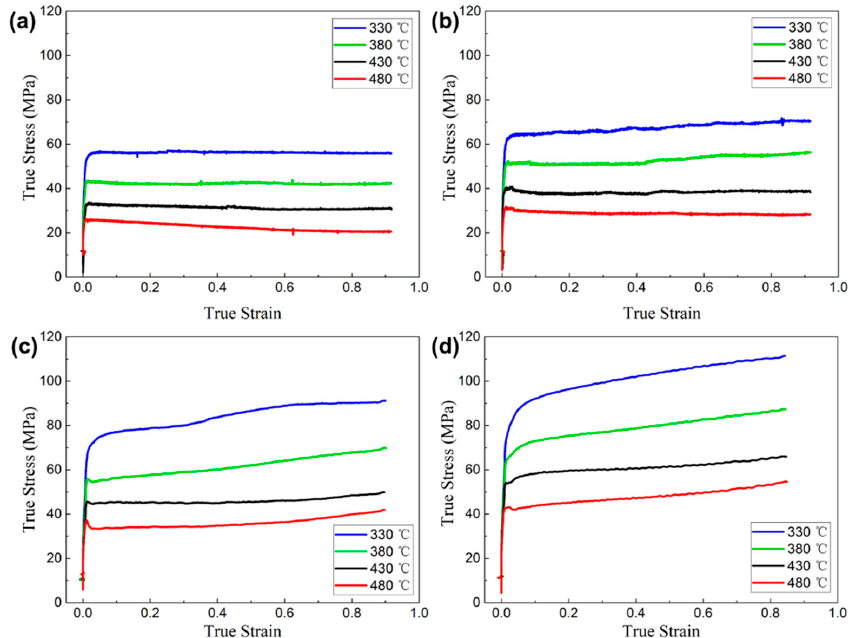
Figure 6. The true stress–strain curve of the third layer of gradient alloy by spray deposition: ( a ) 0.001 s − 1 , ( b ) 0.01 s − 1 , ( c ) 0.1 s − 1 , and ( d ) 1 s − 1 .